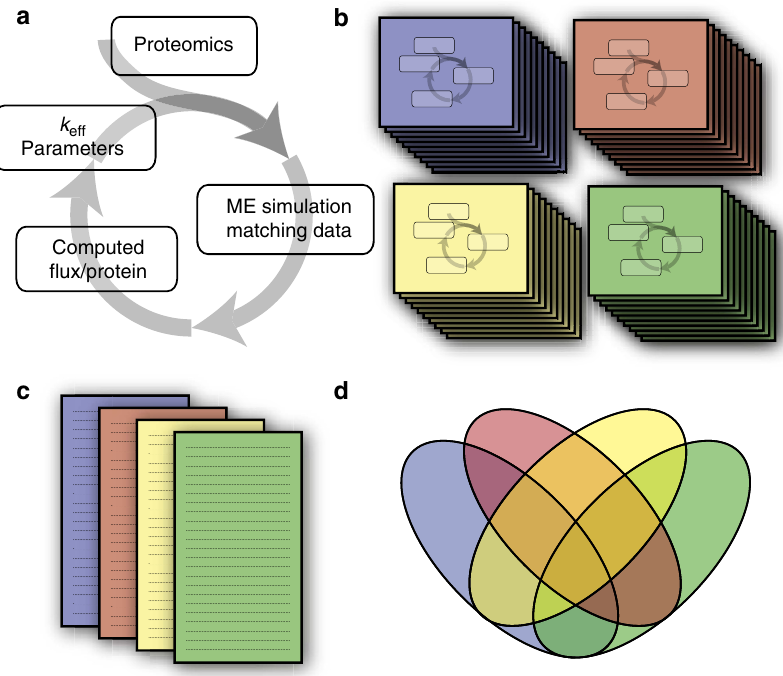
Figure 3 | Iterative workflow for generating turnover rate values from different nutrient conditions. ( a ) An iterative procedure uses a model to find a flux state, which most closely matches experimental proteomic data, and uses it to obtain an estimated parameter set. ( b ) The iterative workflow is run using proteomic data from four different experimental conditions. To eliminate bias from the initial parameters used in the iterative workflow, the starting parameter vectors are sampled from a uniform distribution. ( c ) For each condition, a consensus parameter set is aggregated. ( d ) Parameters are compared between conditions to obtain a universal set of condition-invariant (Fig. 5c) emerges. On the most basic level, a genome-scale model of metabolism informs the user of all possible metabolic reactions and their respective stoichiometries 8 . The previous unpara-